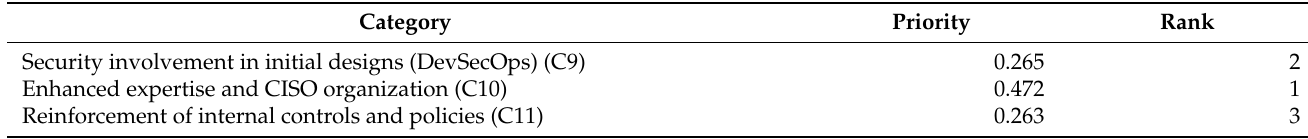
Table 13. Consolidated priorities for D3 sub-criteria.